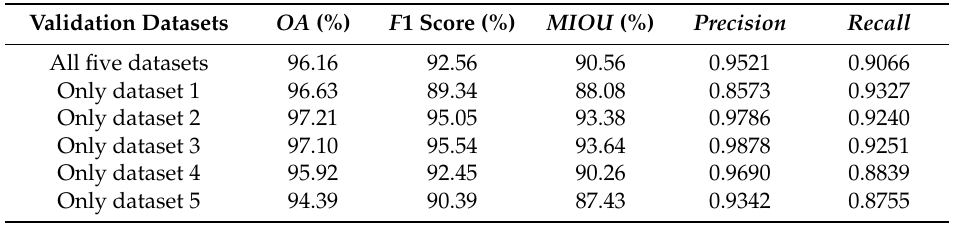
Table 1. Pixel-based evaluation results of the average accuracy for the overall accuracy ( OA ), F 1 score, mean intersection over union ( MIOU ), precision and recall for buildings on all validation datasets and on individual datasets, respectively.